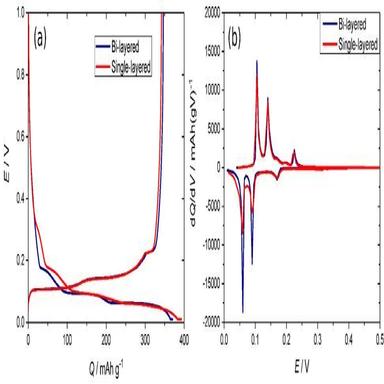
(a) Chronopotentiograms of the formation cycle for the HCCs using Li as counter and reference electrode and the bi- and single-layered graphite coating as working electrode. (b) DVA representation of the formation cycle.